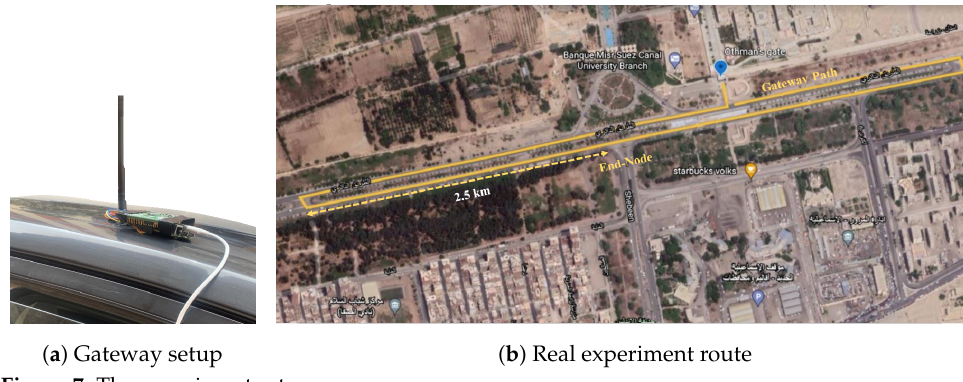
Figure 7. The experiment